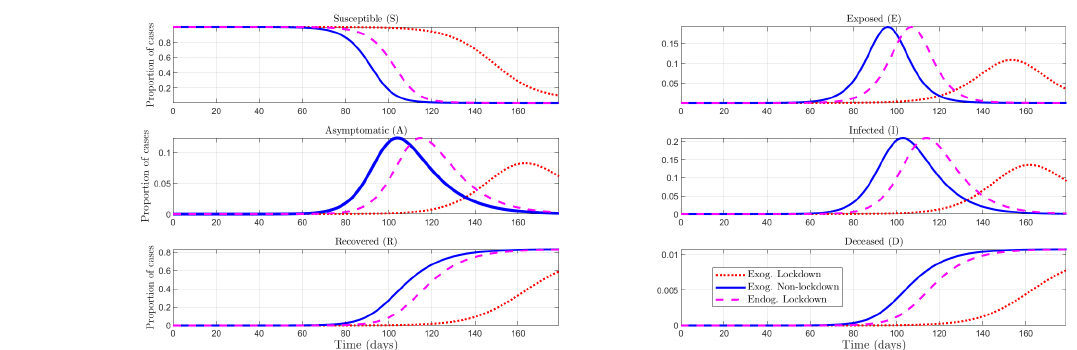
Figure A1. Exogenous lockdown and Non-lockdown vs. endogenous lockdown (Alarm pooling equilibrium).